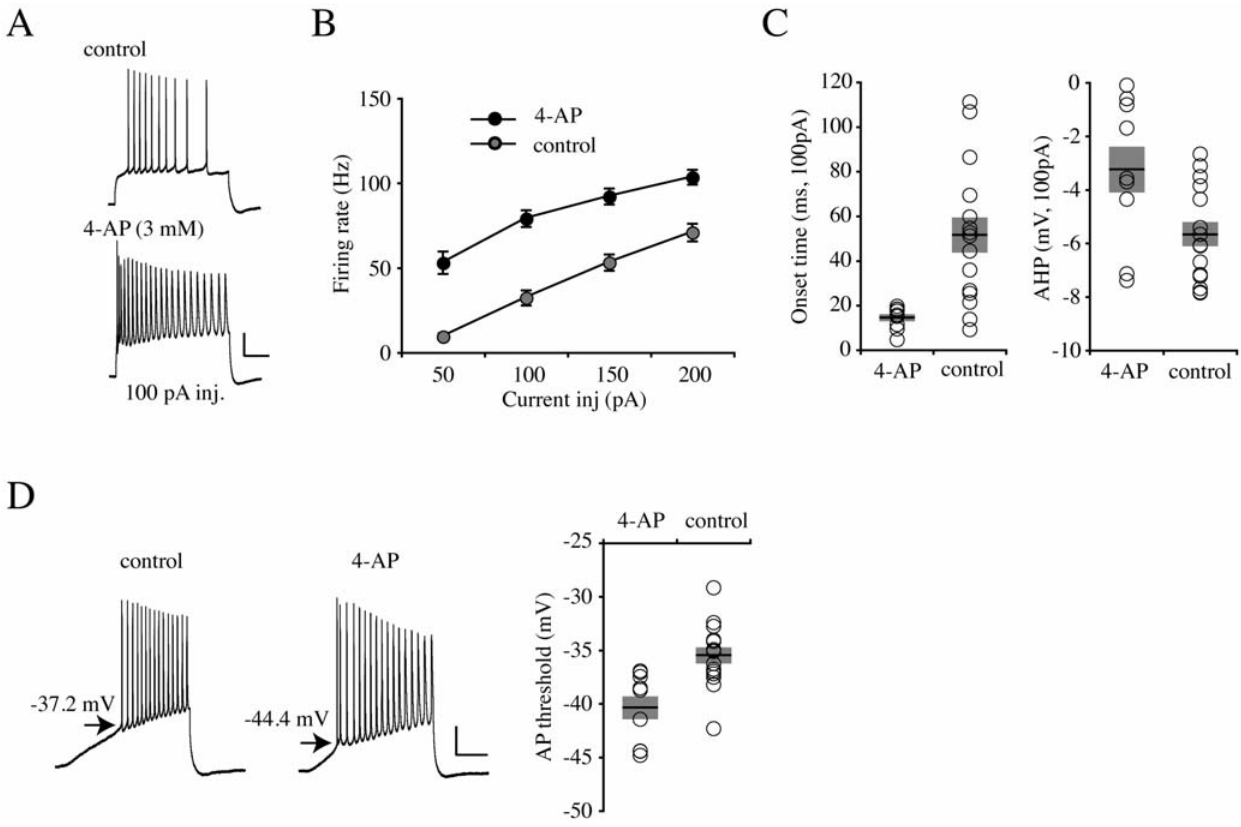
Figure 7. Intracellular 4-AP application increases intrinsic excitability. A . Example traces of AP firing in response to + 100 pA injection in recording 15–30 min after whole cell formation without (control) or with 3 mM 4-AP (4-AP) included in the pipette solution. 4-AP increases onset time and frequency. Scale bars: 20 mV, 200 ms. B . Averaged firing rates. After 4-AP washin, neurons showed a significant increase in AP firing rate. Error bars represent SEM. C . Averaged AP onset time and AHP. Both properties were also decreased by 4-AP addition. Bars indicate the mean values and semitransparent boxes represent SEM. D . Example traces of AP firing after injecting ramp currents (250 pA/s). A significant decrease in AP threshold was observed in the presence of 4-AP. Scale bars: 20 mV, 200 ms. Bars indicate the mean values and semitransparent boxes represent SEM. ization (Figure 8 and Supplemental Figures 3 and 5), demonstrat- ing the requirement of physiological (i.e. synaptic) activity for intrinsic plasticity.